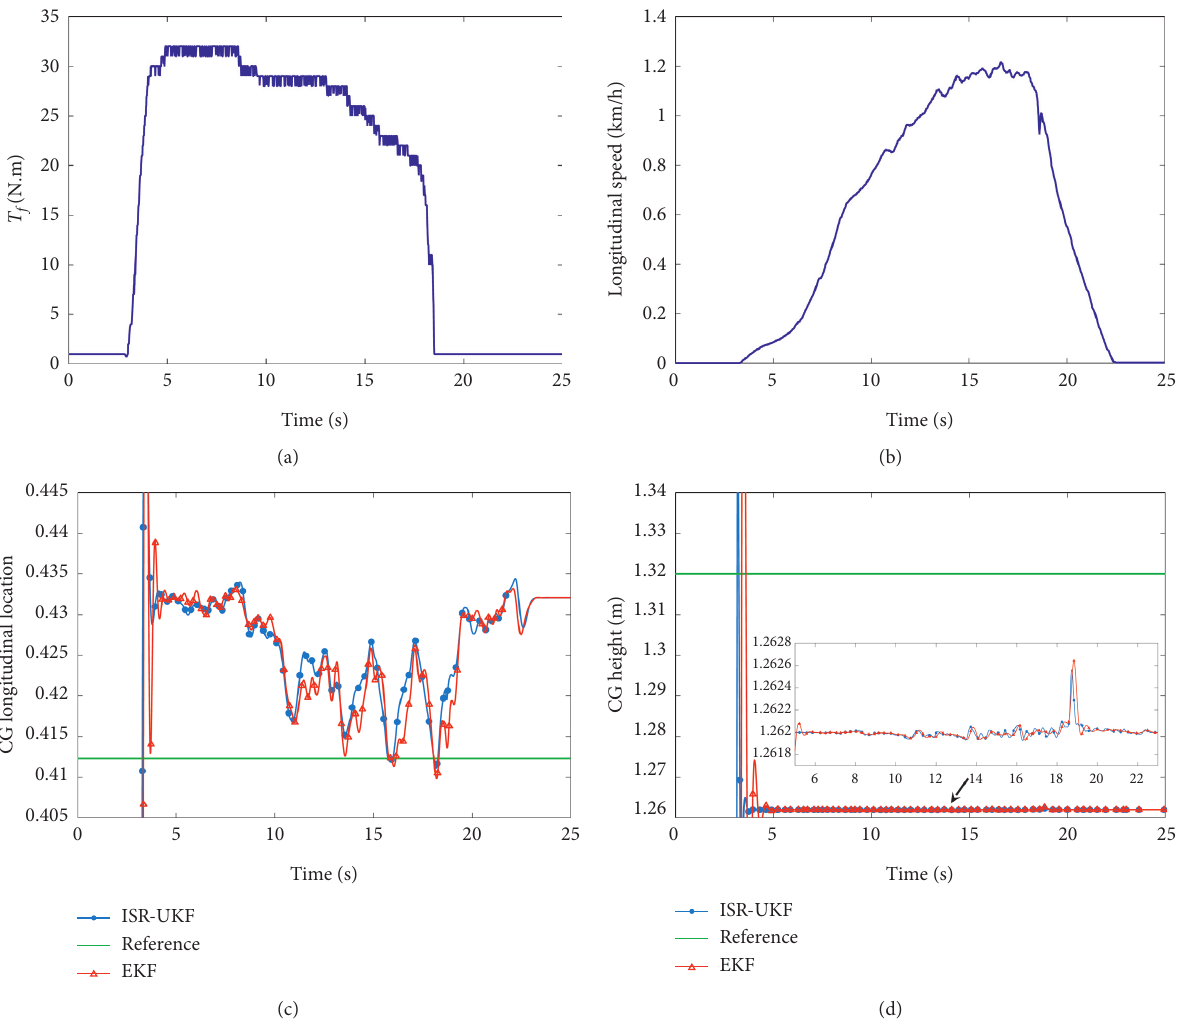
Figure 7: Constant-torque experiment. (a) Output torque of the front motor; (b) longitudinal speed; (c) CG longitudinal location; (d) CG